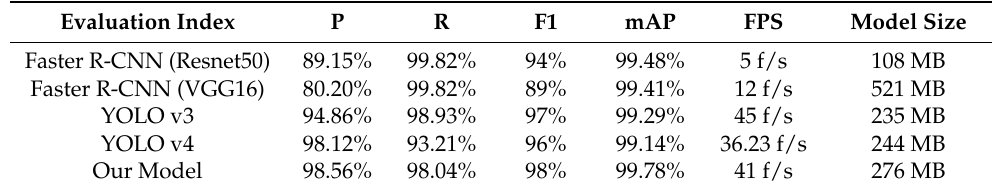
Table 2. Comparison of evaluation indexes of this model and other